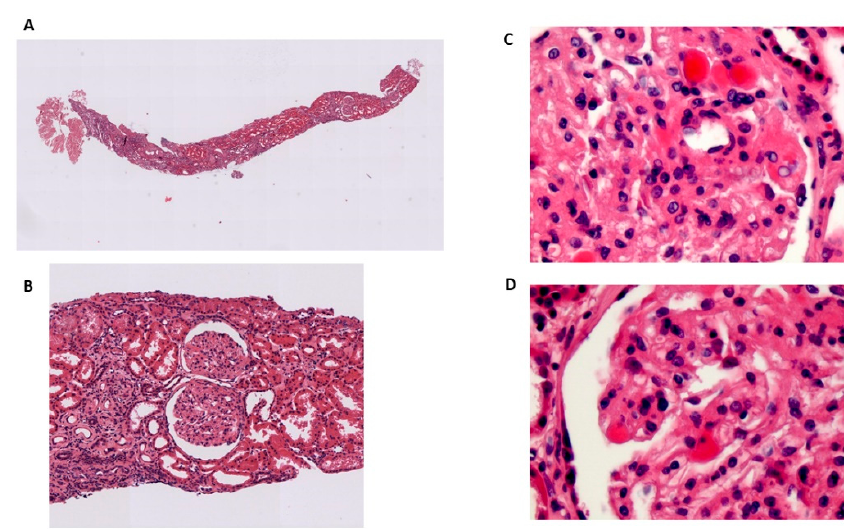
Figure 2. Histological analysis of renal biopsy. ( A ) shows panoramic of the renal tissue cylinder studied; ( B ) shows detail of glomerular involvement, with expansion of the mesangium; ( C and D ) show details of thickening of capillary walls, and presence of foamy lipid deposits at capillary and mesangial level. Genetic analysis of both siblings revealed a homozygous mutation c.605T > C, which is predicted to cause a substitution of isoleucine by threonine at amino acid 202 of LCAT, p.(Ile202Thr). Genetic analysis in the third case showed a homozygous mutation c.512G > A, which is predicted to cause a substitution of arginine by glutamic acid at amino acid 171 of LCAT, p.(Arg171Glu). Both mutations have been classified as pathogenic by bioinformatic analysis (Polyphen-2 [19], MutationTaster [20] and Predict SNP [21]). The first mutation, p.(Ile202Thr), has been previously associated with hypoalphalipoproteinemia in the heterozygosity state by our group [22] (Table